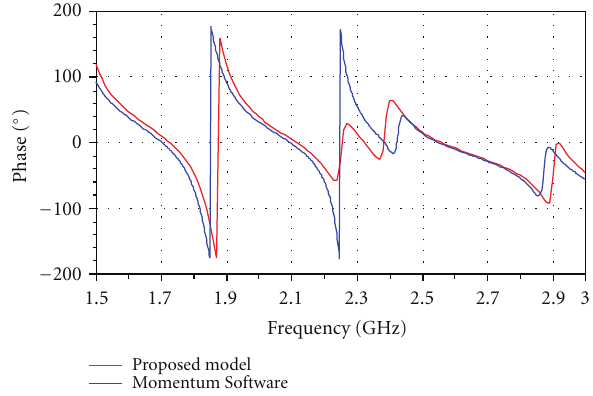
Figure 6: Reflected phase at the antenna array input.